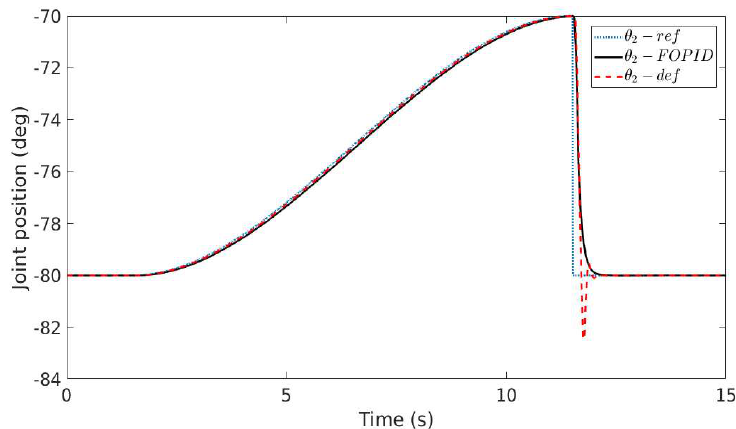
Figure 8. Step response of the UR10 robot for joint 2—the second robot configuration (ref = reference signal, FOPID = closed loop response with FO-PI controller in (23), def = default robot PID controller).